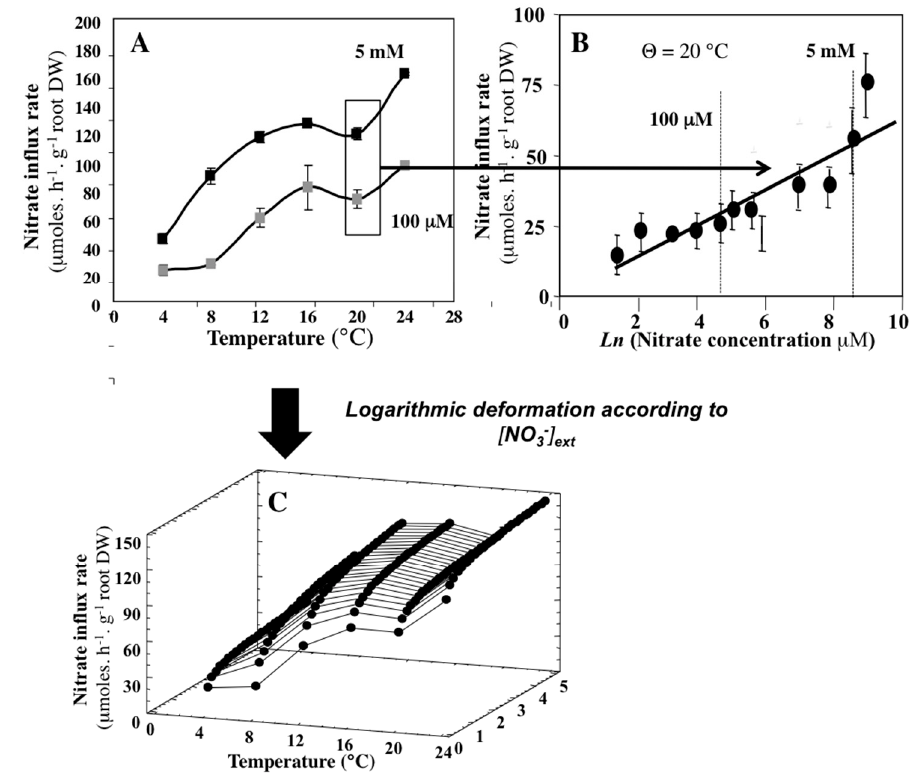
Figure 7. Example of a cross-combination between temperature effect on nitrate influx rate and external nitrate concentrations within a flow–force framework. ( A ) Temperature effect on nitrate influx rate at 100 µ M and 5 mM. ( B ) Nitrate influx rate isotherm with B. napus plants at B4 stage, grown at 20 ◦ C and 300 µ mol m 2 s − 1 PAR under a 16/8 h day–night regimen. ( C ) Three-dimensional plot of the temperature effect on nitrate influx rate variations within a flow–force framework after logarithmic deformation in interval 100 µ M to 5 mM external nitrate concentrations.